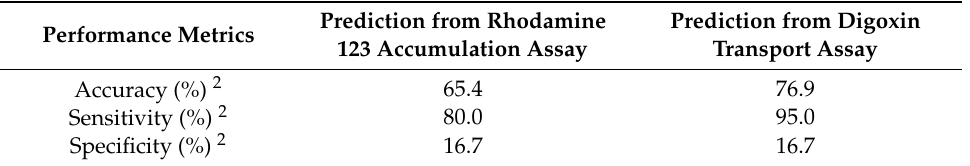
Table 3. Accuracy, sensitivity, and specificity of the prediction of clinical P-gp interactions with IC 50 values generated from rhodamine 123 accumulation or digoxin bidirectional transport [41] assays, according to FDA criteria 1